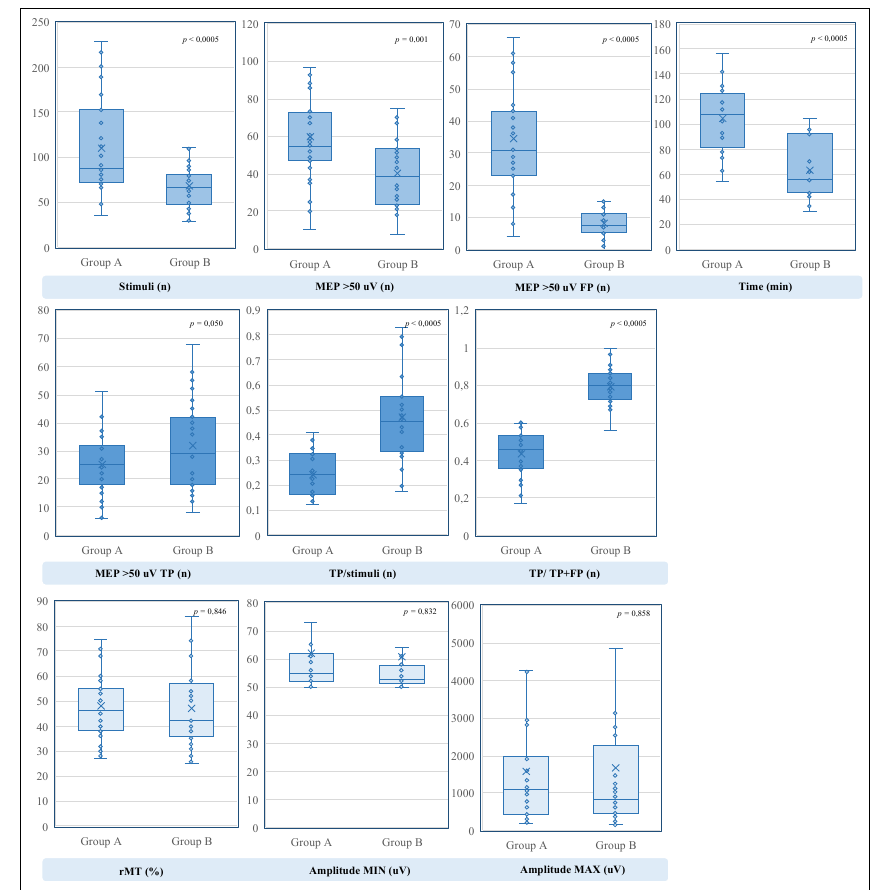
Figure 4. Graphical representation of the comparison between the parameters of group A and group B with their respective significance values. At the top, the parameters that showed significant decreases are grouped. In the middle, the parameters that increased are shown. In the lower part, the parameters that did not show significant differences are grouped. The statistical significance was set at p < 0.05 (MEP, motor evoked potential; TP, true positive; FP, false positive; rMT, resting motor threshold).